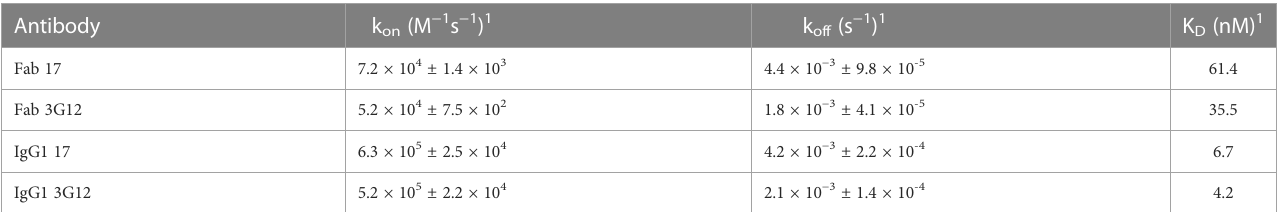
TABLE 1 Blitz results of human ENPP1 antibodies. Antibody